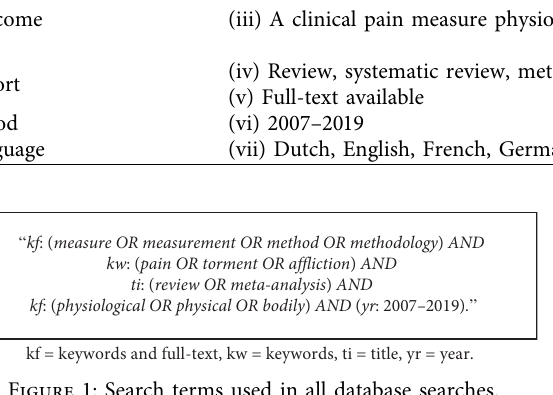
Figure 1: Search terms used in all database